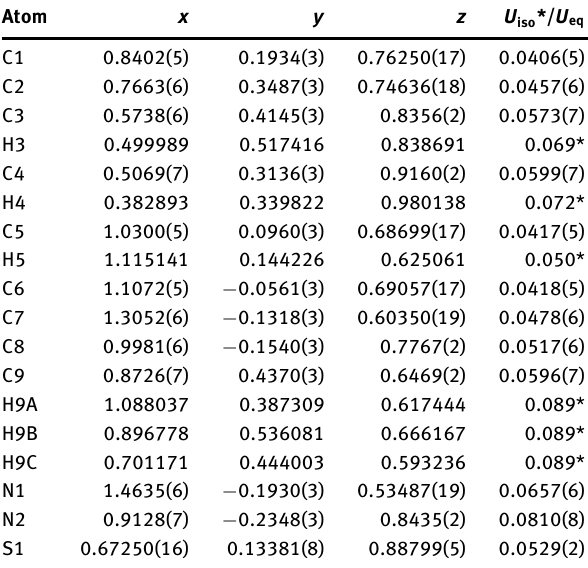
Table 2: Fractional atomic coordinates and isotropic or equivalent isotropic displacement parameters (Å 2 ).